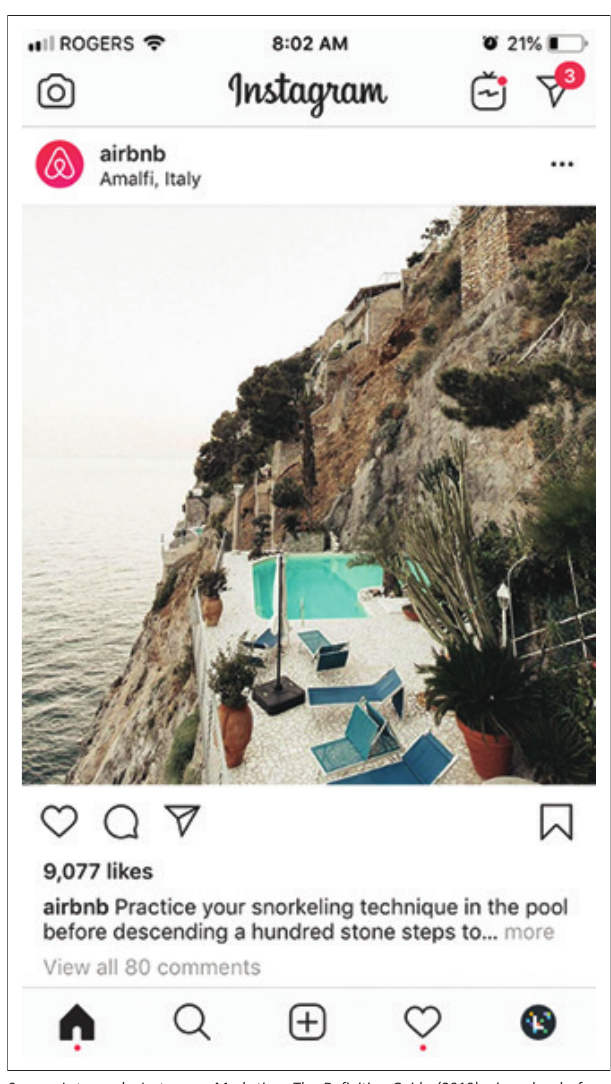
FIGURE 1: An Instagram homepage platform.